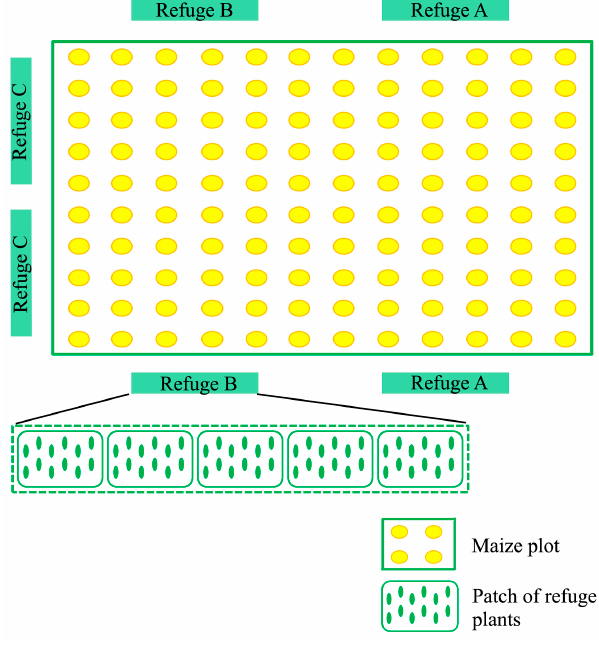
Figure 1. Sampling design of the field experiment.